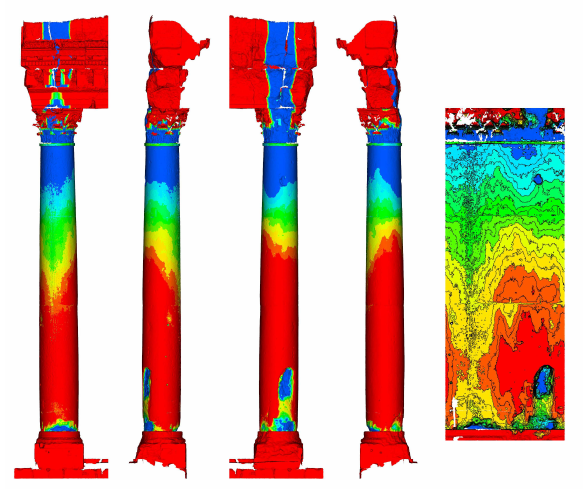
Figure 6: Analysis of the shape of a column of the temple of Jupiter, Baalbek,